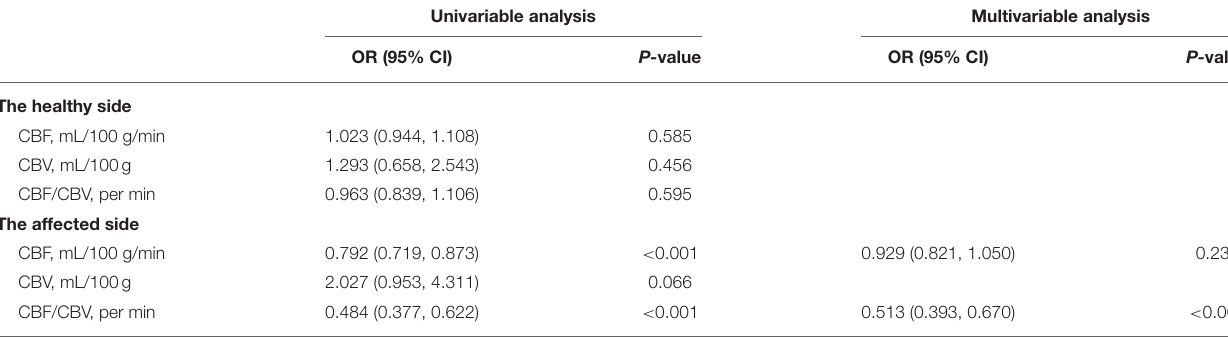
TABLE 4 | Comparison of CTP parameters between asymptomatic and symptomatic